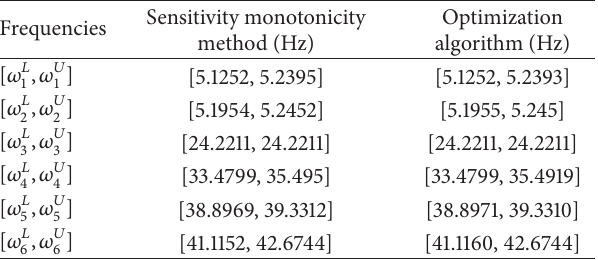
Table 2: Natural frequency intervals of GARTEUR